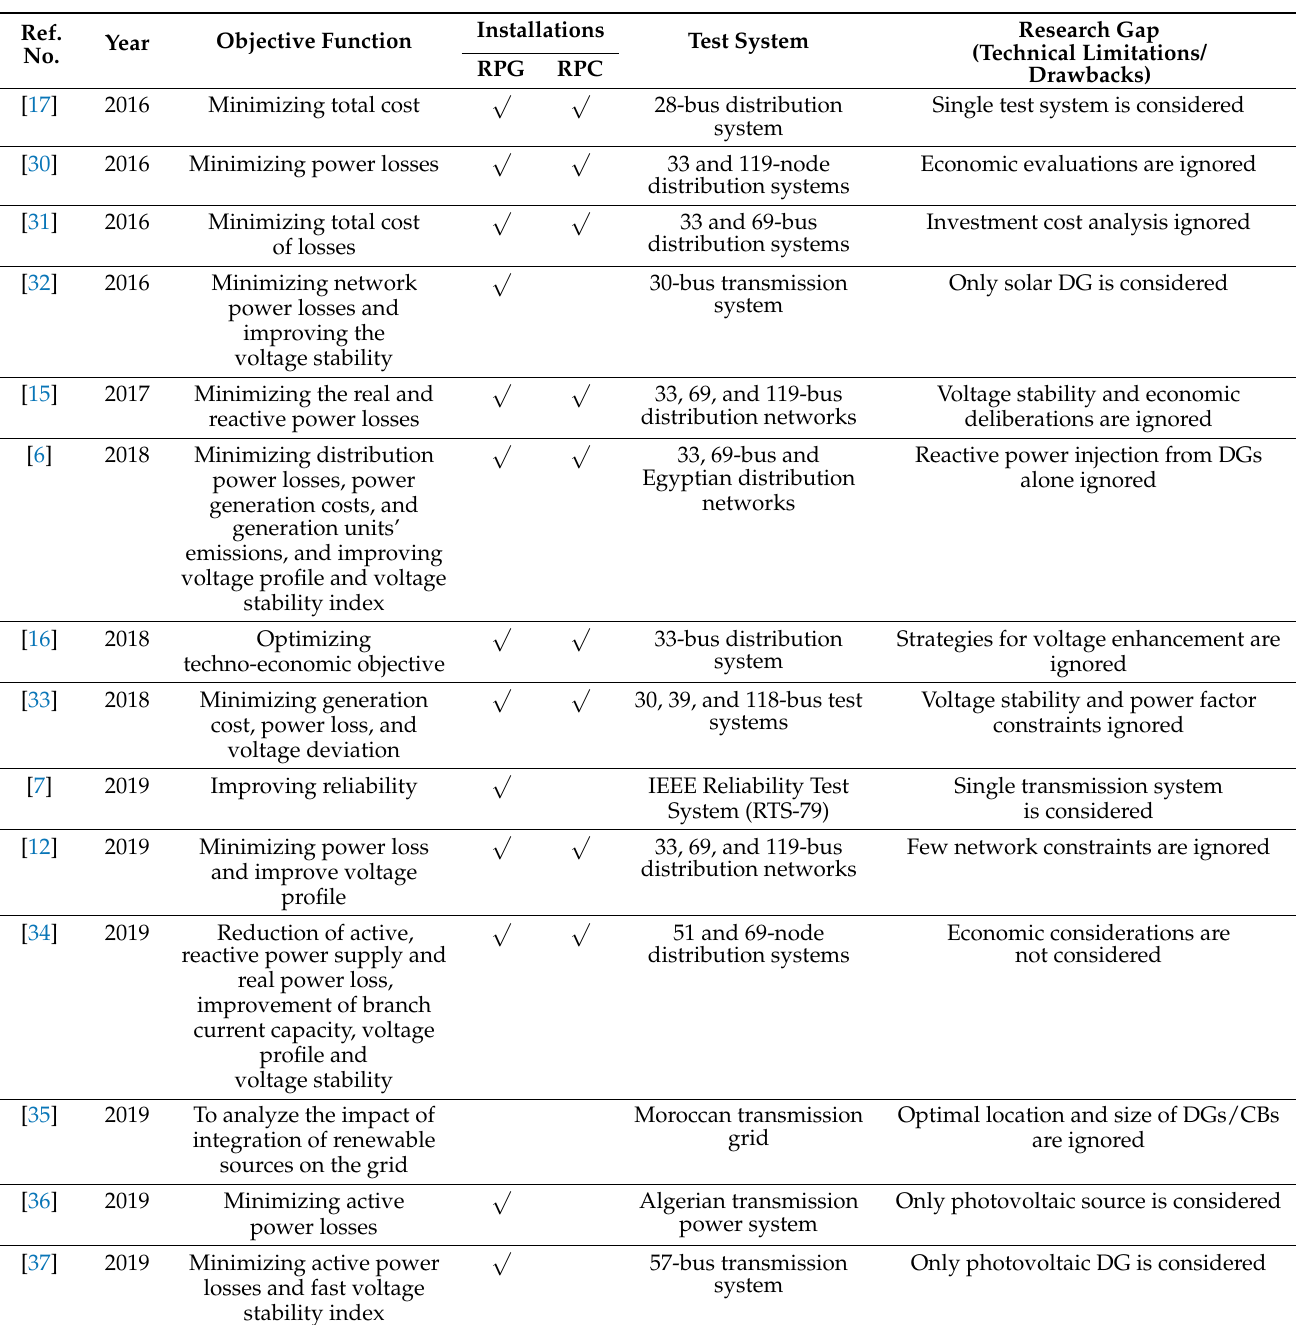
Table 1. Summary of recent works related to the optimal installation of renewable power generations (RPGs) and reactive power compensators (RPCs). Ref.